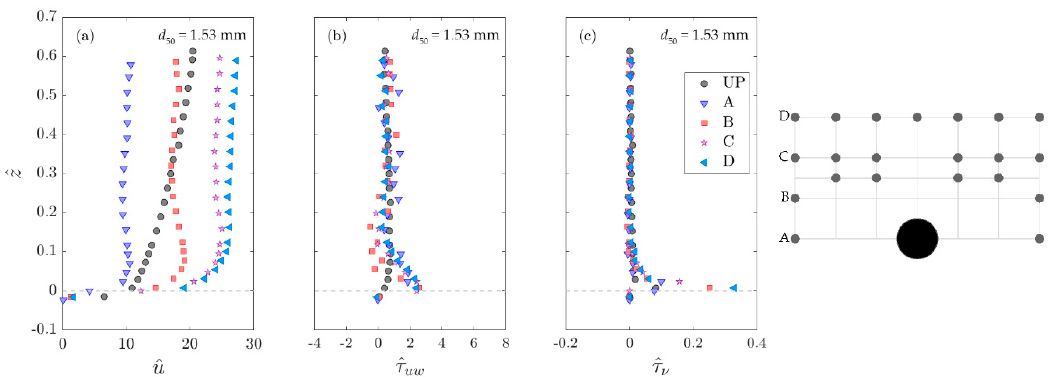
Figure 14. Vertical distributions of ( a ) dimensionless time-averaged velocity, ( b ) dimensionless Reynolds shear stress, and ( c ) dimensionless viscous shear stress measured at x = 0 in Run 1. Water 2020 , 12 , x FOR PEER REVIEW